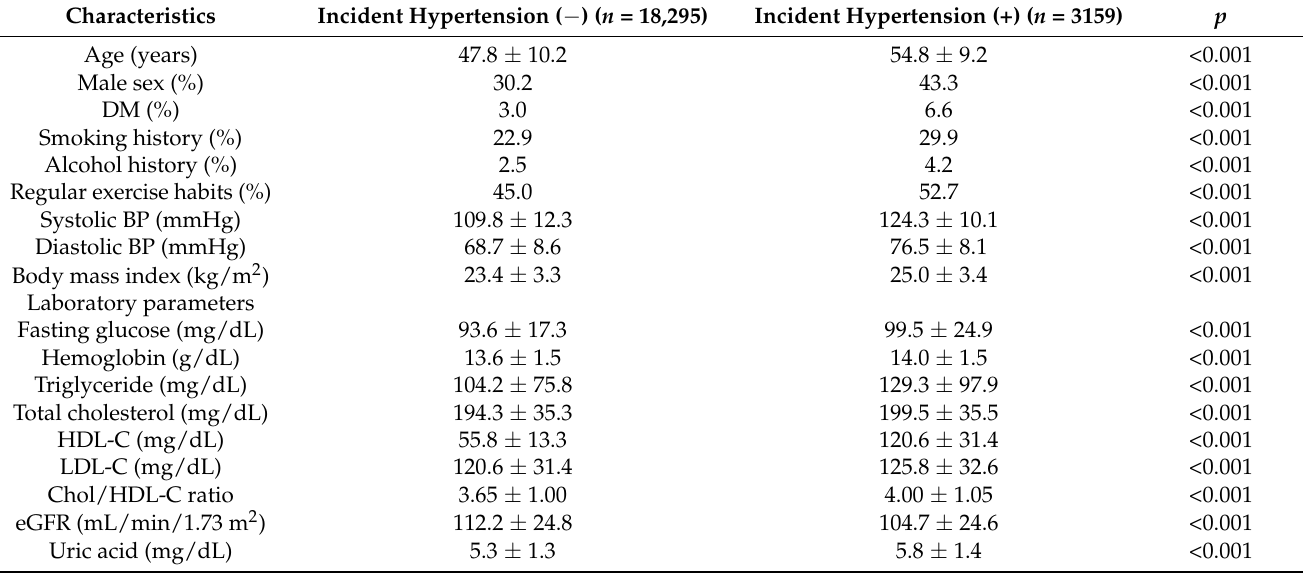
Table 3. Comparisons of clinical characteristics between the participants with and without incident hypertension ( n =